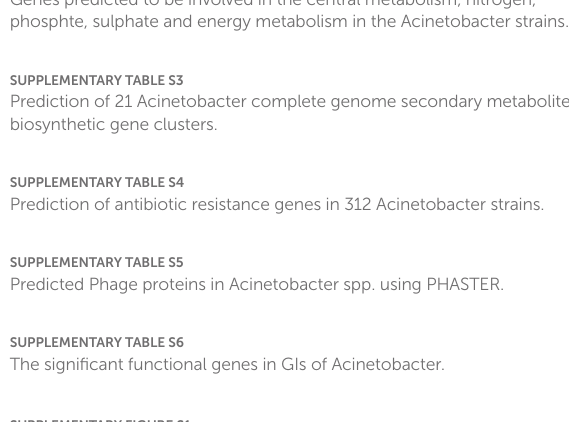
SUPPLEMENTARY TABLE S1 Basic Information of 312 Acinetobacter